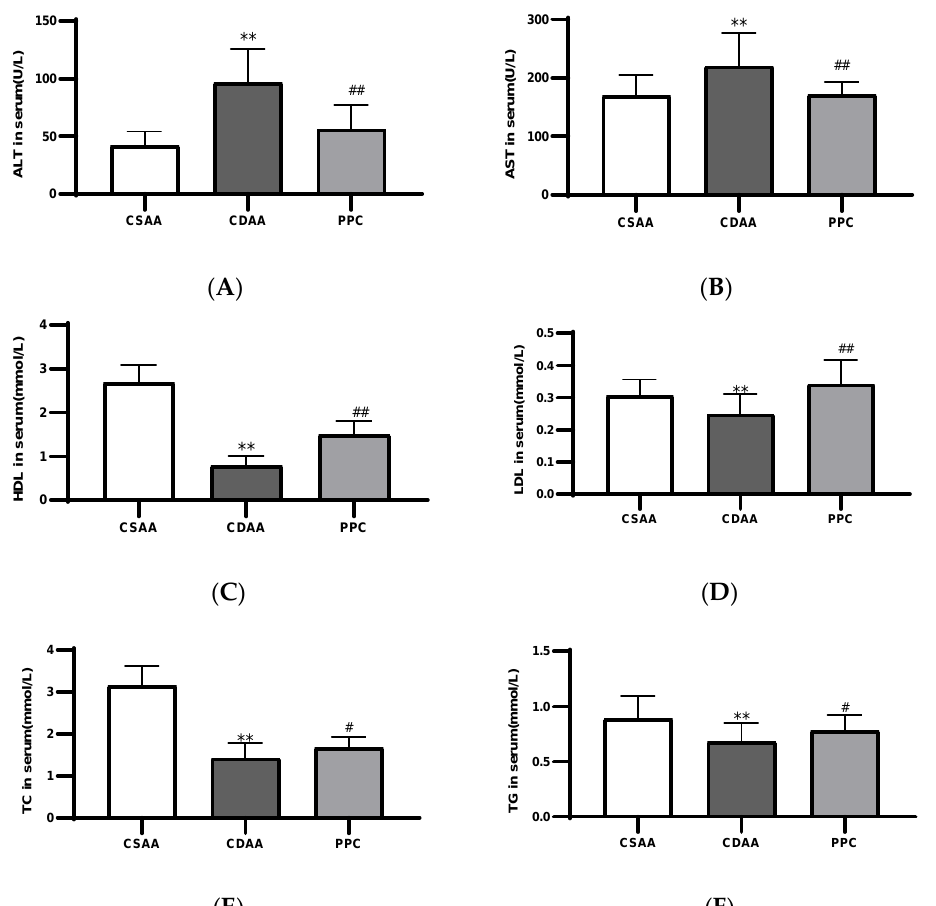
Figure 4. Serum levels of ALT ( A ), AST ( B ), HDL ( C ), LDL ( D ), TC ( E ), and TG ( F ) in the CSAA,